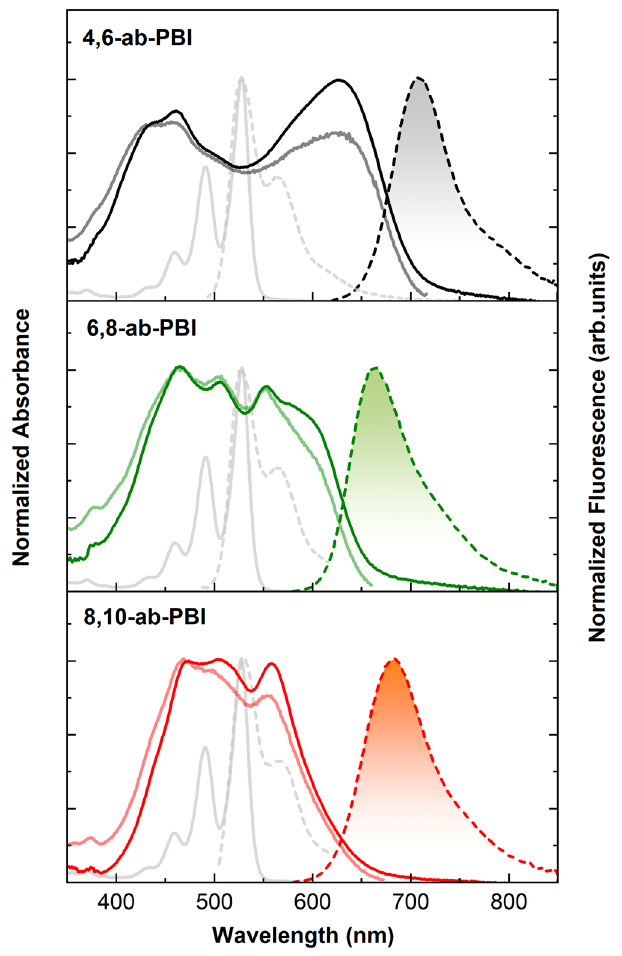
Fig. 3 | Basic optical properties of 4,6-, 6,8-, 8,10-ab-PBI. Normalized UV-vis absorption(solidlines),excitation(lightsolidlines)and fl uorescence(dashedlines with fi lled area) spectra of 4,6-, 6,8-, 8,10-ab-PBI (top to bottom) annealed spin- coated thin fi lms on quartz substrates, respectively (Supplementary Fig. 22). Gray solid and dashed lines show the absorption and fl uorescence spectra of the monomers in chloroform solutions (1×10 − 5 M for UV-vis absorption spectra and 1×10 − 7 M for fl uorescence spectra).